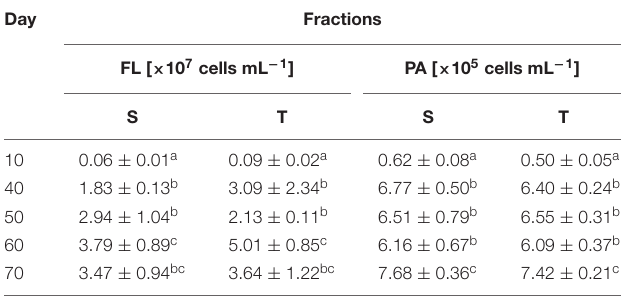
TABLE 2 | Total bacterial cell numbers in the free-living (FL) and the particle attached (PA) fractions. Day